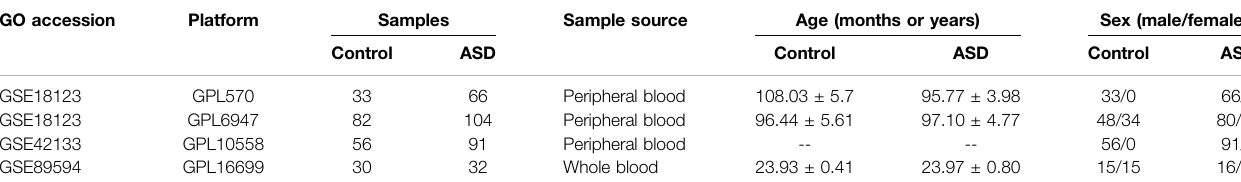
TABLE1 | Information for ASD-related datasets.